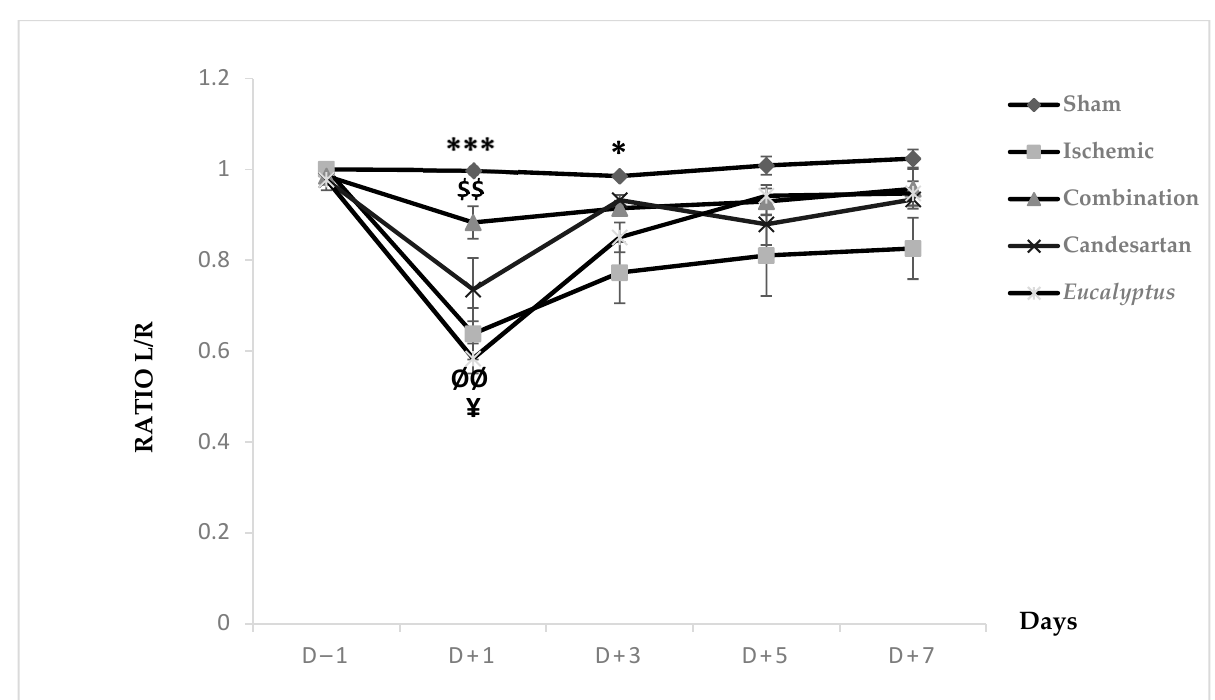
Figure 4. Modified sticky tape test (MSTT) results. MSTT graph showing Left to Right (L/R) ratio of time for scotch sensation done on days (–1, +1, +3, +5, +7) for Sham (n = 6), Ischemic (n = 11), Ischemic treated with a combination of Candesartan and Eucalyptus (n = 10), Ischemic treated with Candesartan (n = 5), and Ischemic treated with Eucalyptus (n = 5) groups. $$ p < 0.01 for a significant difference between Ischemic and Ischemic treated with Combination of Candesartan and Eucalyptus ; * p < 0.05; *** p < 0.001 significant difference between Ischemic and Sham; ¥ p < 0.05 for a significant difference between Ischemic treated with Combination and Eucalyptus only; ØØ p < 0.01 for a significant difference between Sham and Eucalyptus only.